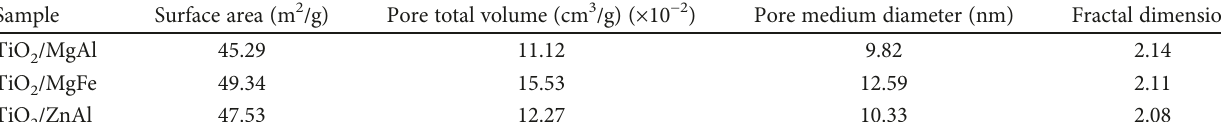
-LDH materials. 2